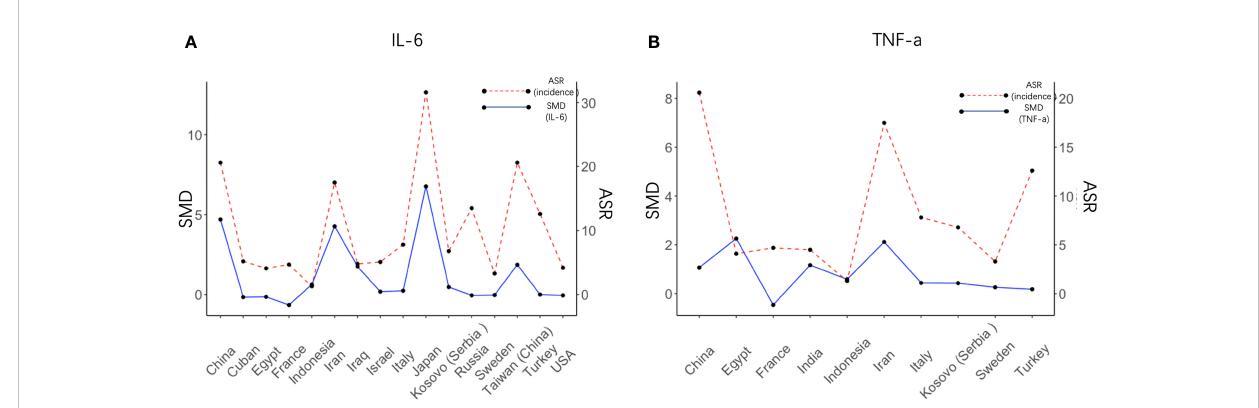
FIGURE 4 Regional IL6 levels induced by H. pylori correlate with cancer risk in these regions. Visual representation of the correlation between the SMD of IL-6 (A) and TNF- a (B) after H. pylori infection in different countries (left axis) and the value of the risk of gastric cancer in these countries (right axis). SMD, Standardized Mean Difference; ASR, Age-Standardized Rate